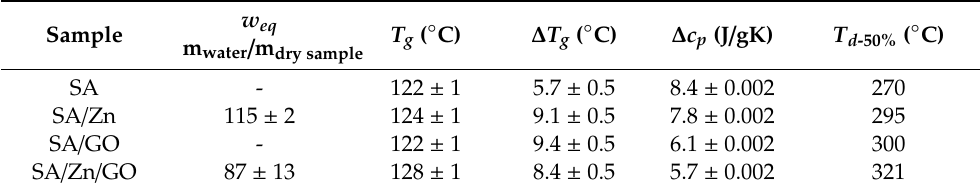
Table 1. Swelling degree in equilibrium ( w eq ), glass transition temperature ( T g ), width of the glass transition ( ∆ T g ), heat capacity increment at the glass transition ( ∆ c p ), and decomposition temperature at which weight loss was 50% ( T d- 50%